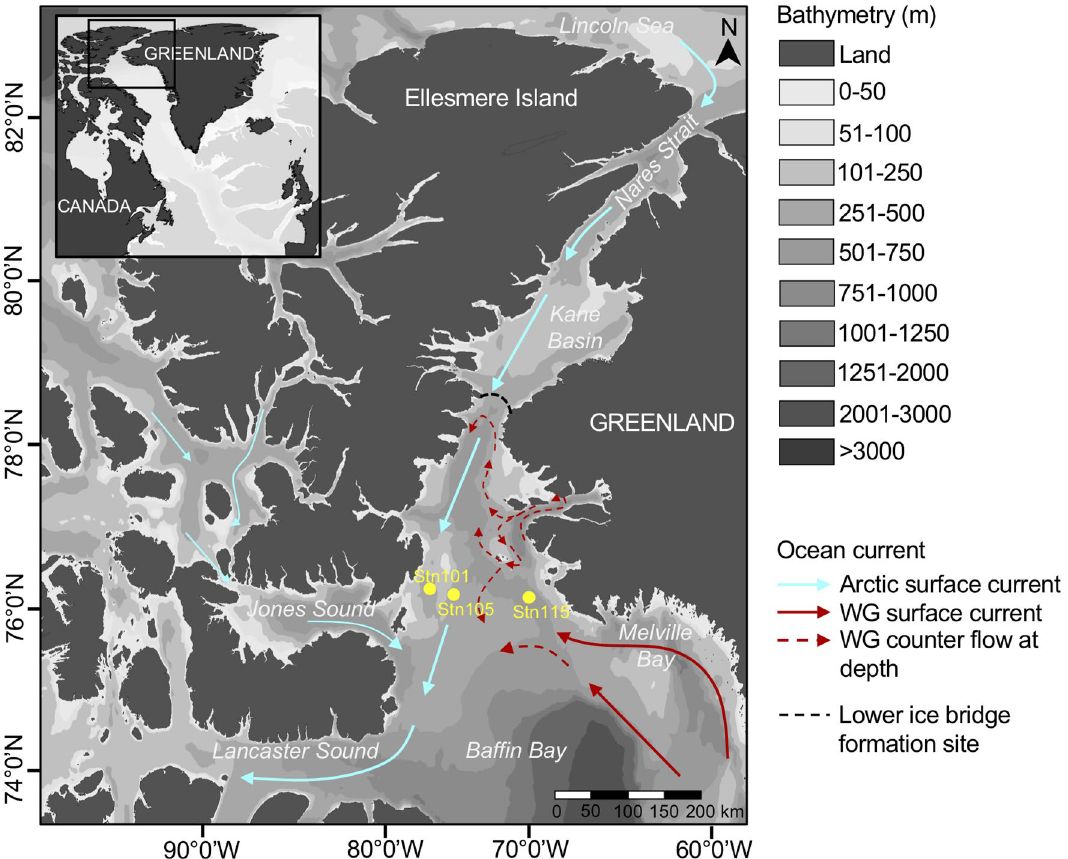
Figure 1. Map of the sampling region. Circulation within the North Water region from Melling et al . 62 . Light blue arrows show colder and less salty surface water and red arrows display warmer and saltier surface water. Samples are from the Greenland side (Stn115) and the Canadian side (Stn101 and Stn105). West Greenland current (WG). The map was generated using Ocean Data View (v.4.7.8, http:// odv. awi. F = 1.84, p < 0.05). Summer communities were associated with warmer temperatures (ANOVA: R 2 = 0.05, F = 5.7, p < 0.001) and longer day-length (ANOVA: R 2 = 0.03, F = 3.16, p < 0.01). The summer samples were more dis- persed along the second axis, associated with temperature and salinity. The second axis of both the db-RDA and constrained correspondence analysis (CCA) plots highlighted oxygen and salinity as further potential environ- mental filters, with some clustering suggesting separation of West–East communities along with depth category. The Canadian and Greenland sides were examined separately, using PerMANOVA to test for the significance of environmental variables correlated with the combined communities (Supplementary Table S6). The test indi- cated that on the Canadian side, temperature and salinity were the main drivers of community differences. Temperature was also significant for the Greenland communities but not salinity. However, differences in silicate concentrations between depths were significant on the Greenland side (Supplementary Table S7). The Non-Metric multiDimensional Scaling (NMDS) plot based only on communities, separated the samples by season but added more weight to three 2018 samples (Supplementary Fig. S4). The generally greater disper- sion of the summer samples was evident in seasonal Venn diagrams of OTUs from the two sides (Fig. 4b). There were more side specific OTUs in July–August (West: ca. 25%; East: 20%) compared to the October samples with less than 15% for either side. Examining all samples combined, we found ca. 16% of OTUs were unique to one side or the other, with ca. 68% shared.